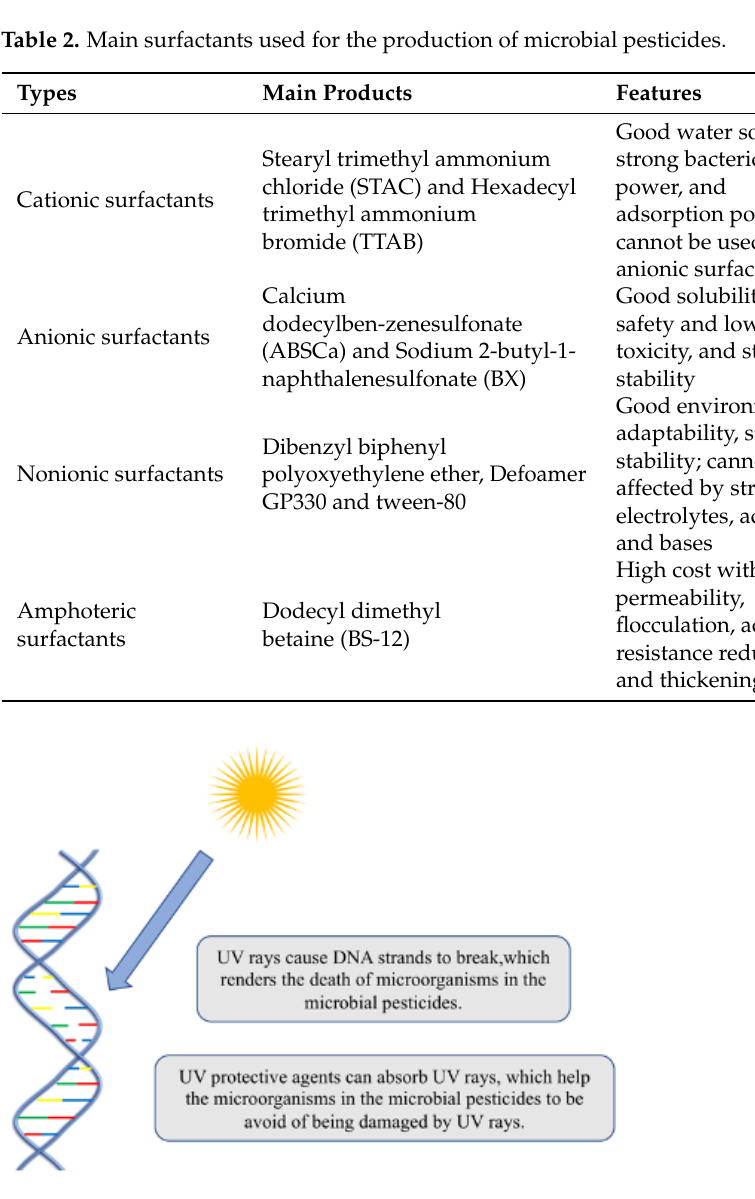
Figure 2. Added protective agents in the microbial pesticides to avoid damage by UV rays. (2) Other protective agents Microorganisms in microbial pesticide preparations are easily affected by adverse factors such as temperature, humidity, and oxidation during storage and transportation,